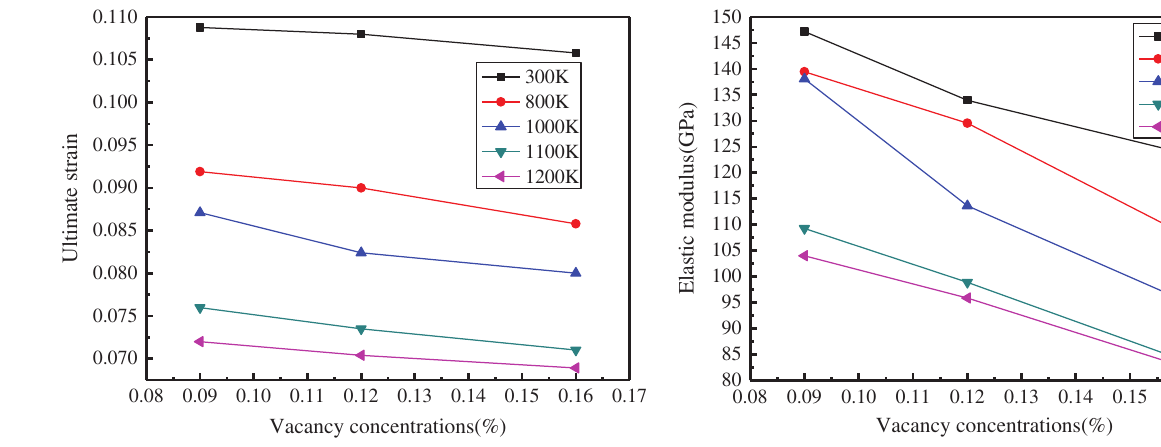
Figure 6: Ultimate strain curves at different temperatures and vacancy concentrations.